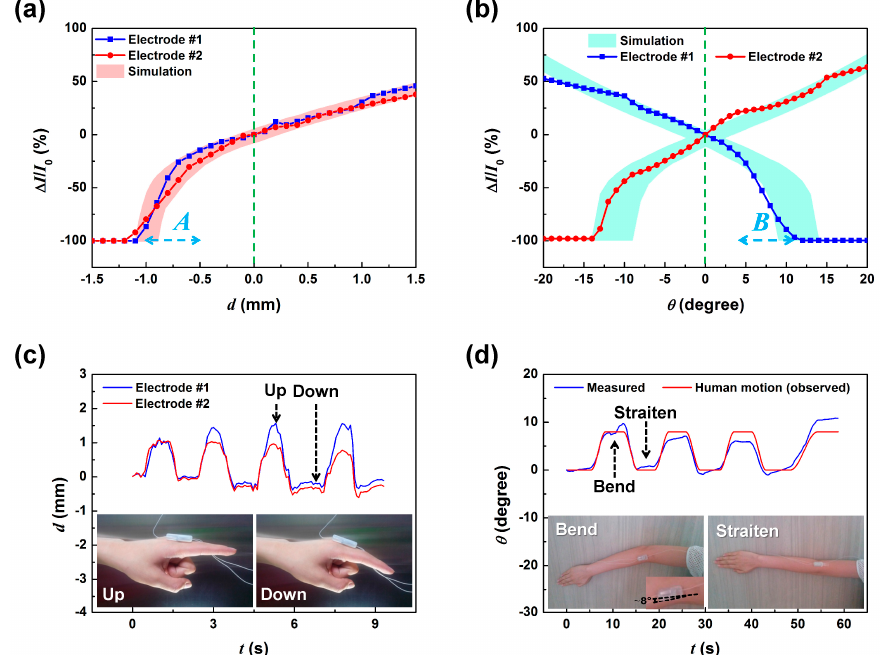
Figure 6. The displacement and rotation angle sensing characteristics of the dSMP sensor; the measured Δ I / I 0 of the two lower electrodes depending on applied ( a ) displacement and ( b ) rotation. The pink area represents the simulated output variation, originating from a lateral position error of ±100 μ m and a rotation error of ±3 degrees, and the cyan area represents the simulated output variation from an SMP position variation of ±100 μ m; ( c ) human forefinger movement sensing result. The insets show the image of the up, and down motion of a human forefinger with the dSMP sensor attached to the proximal phalanx; ( d ) human elbow movement sensing result. The insets show the image of the eight degree bending and straitening motions of a human elbow with the dSMP sensor attached to the side of the elbow joint.